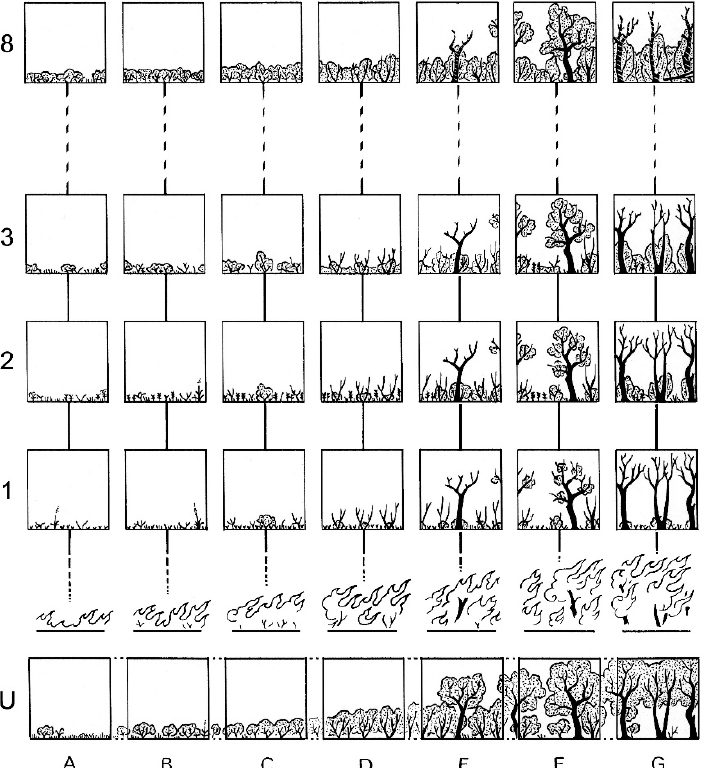
Figure 2. Diagram of the sampling design: sampling stations were selected in seven vegetation classes in a unburned grassland-to-woodland gradient ( x -axis), then monitored for eight years after a fire ( y -axis). ( A )—grasslands, with scattered scrub; ( B )—low and patchy scrub; ( C )—low maquis; ( D )—closed heather maquis; ( E )—maquis with scattered oaks (holm oaks or cork oaks); ( F )—clear and open cork oak forest; ( G )—closed and dense holm oak forest.